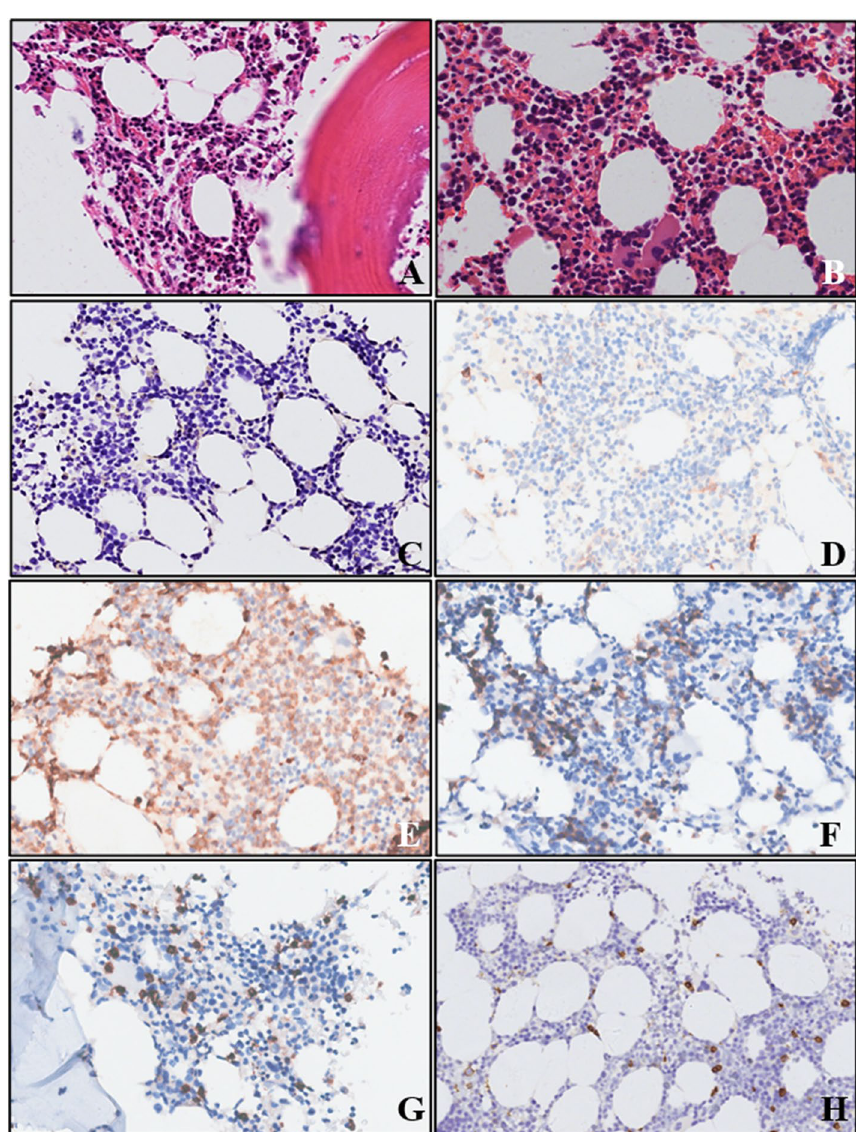
Fig. 3 Bone marrow biopsy. A and B Normocellular marrow with trilineage hematopoiesis (hematoxylin and eosin stain, A , magnification; B , 400 magnification). C and D No obvious aggregation of mast cells, as shown by CD25 ( C ) and CD117 ( D ) immunostaining × (immunohistochemistry, 200 magnification). E , F , G , H Expression of MPO ( E ), CD71 ( F ), CD3 ( G ), and CD20 ( H ) as the erythroid, myeloid, and × lymphoid markers, respectively (immunohistochemistry, 200 ×